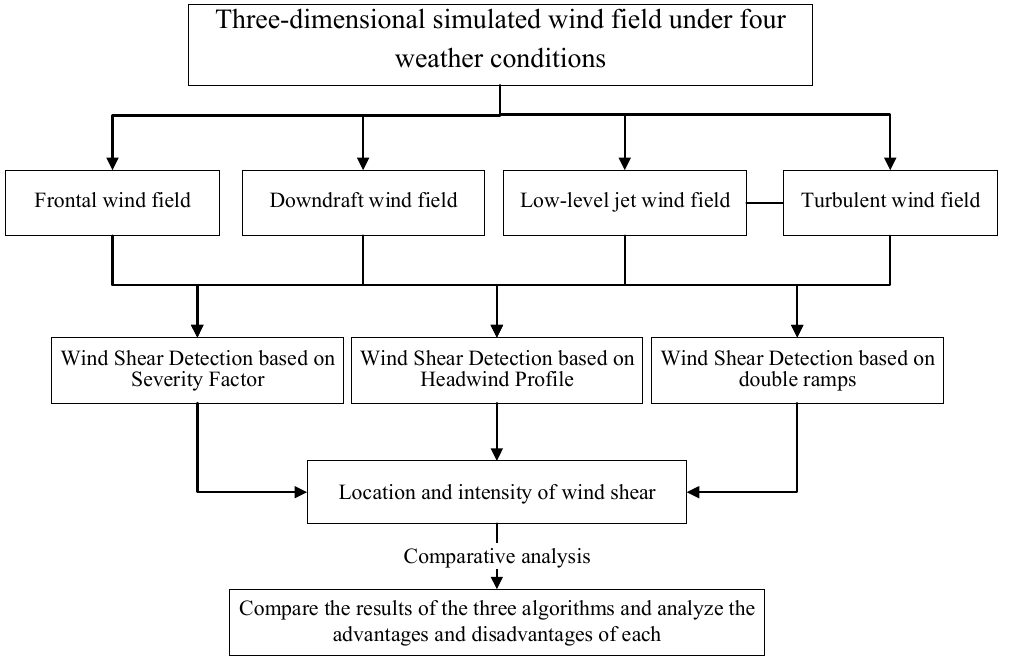
Figure 5. Framework of the project in this